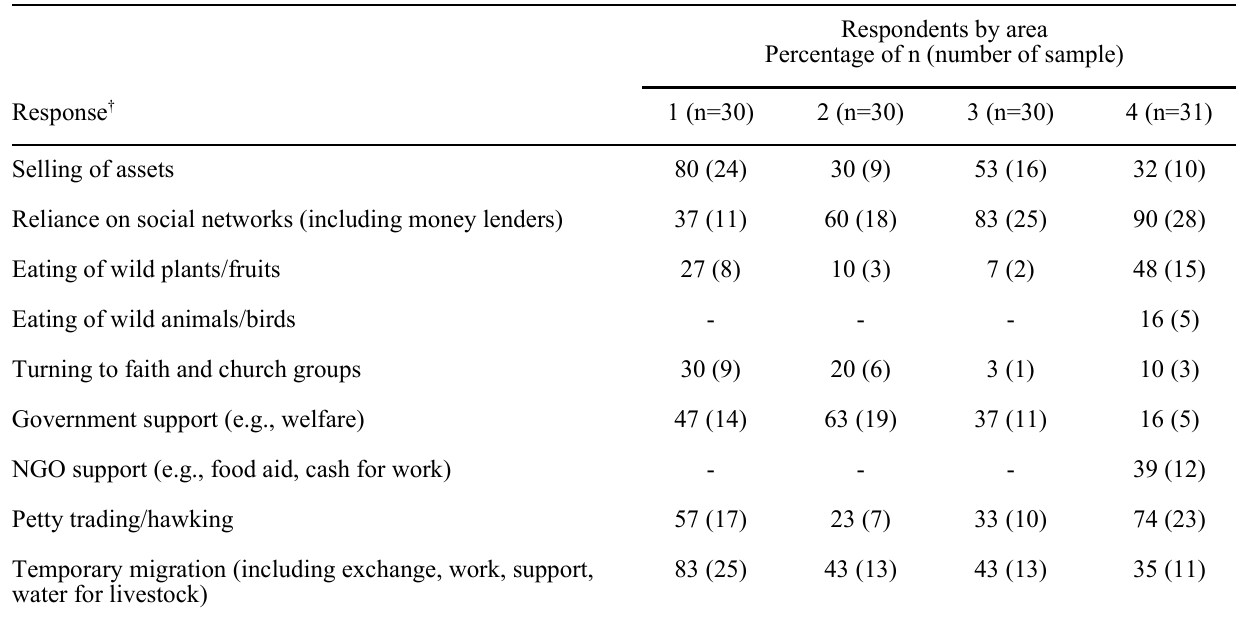
Respondents by area Percentage of n (number of